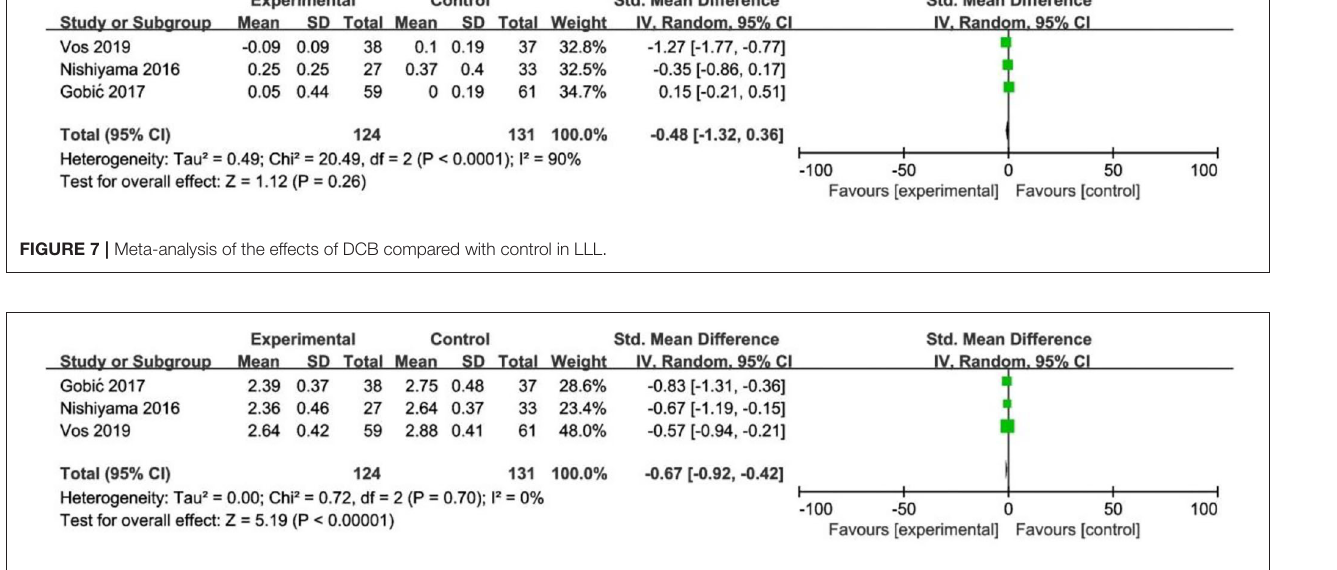
FIGURE 8 | Meta-analysis of the effects of DCB compared with control in